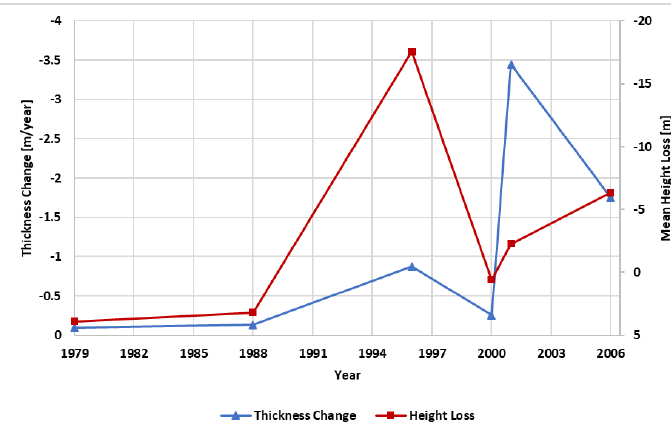
Figure 6 . Brenva Glacier's average height and thickness change rate throughout